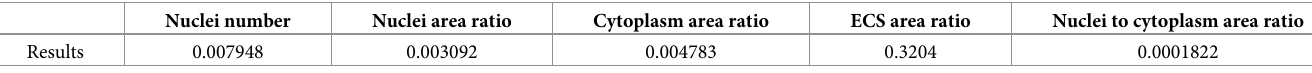
Table 9. Wilcox rank sum test results for the difference of high and low grade features.